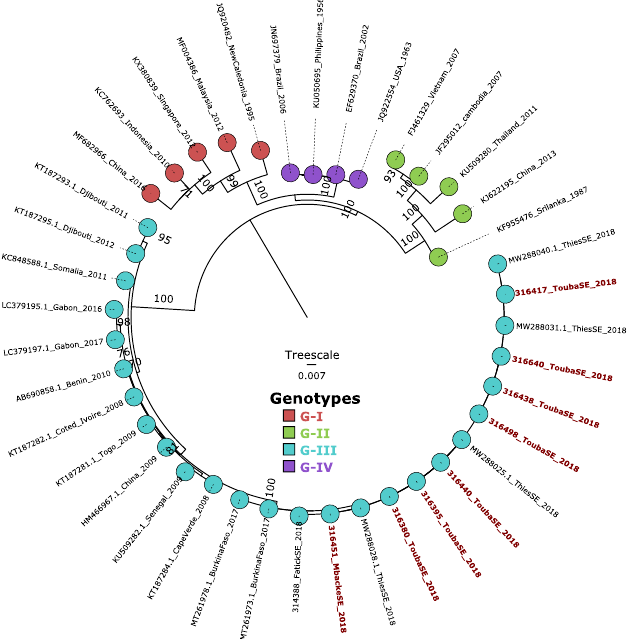
Figure 5. Maximum likelihood (ML) phylogenetic tree inferred by using non-identical sequences from the Touba outbreak (highlighted in red) and those from other regions of Senegal (Thiès and Fatick, sampled in 2018) in combination with strains representative of the described DENV-3 geno- types. Bootstrap support (greater than 75) is represented on each node; scale bar represents the number of observed substitutions per site. Genotypes are represented by different colors according to the legend. The performed phylogeographic analysis of sequenced viruses revealed that isolates form a monophyletic cluster which originated in Burkina Faso and were introduced in Touba, Senegal (location probability = 0.68; posterior = 1). It also suggests a single intro- duction possibly took place around 2017.07 (95 % HPD = 2016.61 – 2017.57) and then spread to the Thiès region (Figure 6).